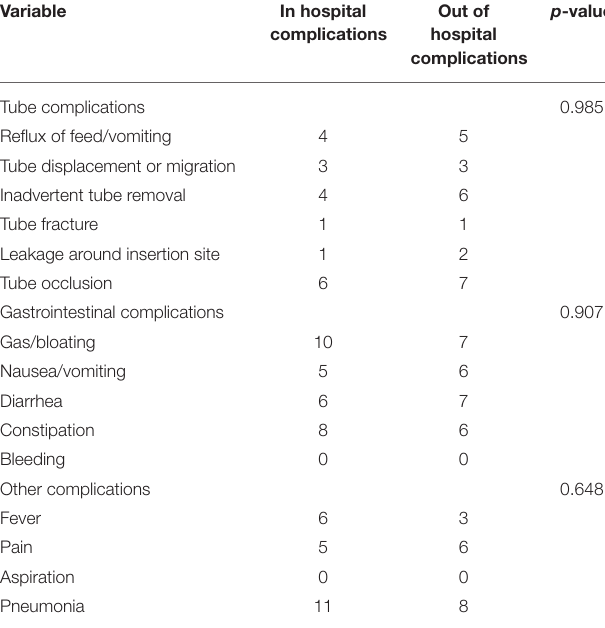
TABLE 6 | Complications of